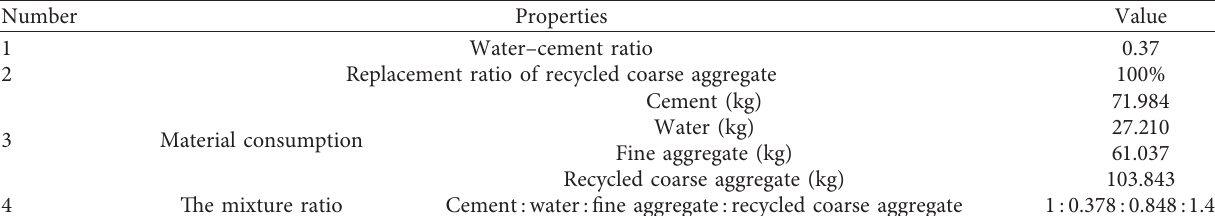
Table 4: The mixture ratio, water-cement ratio, and replacement ratio of recycled coarse aggregate.